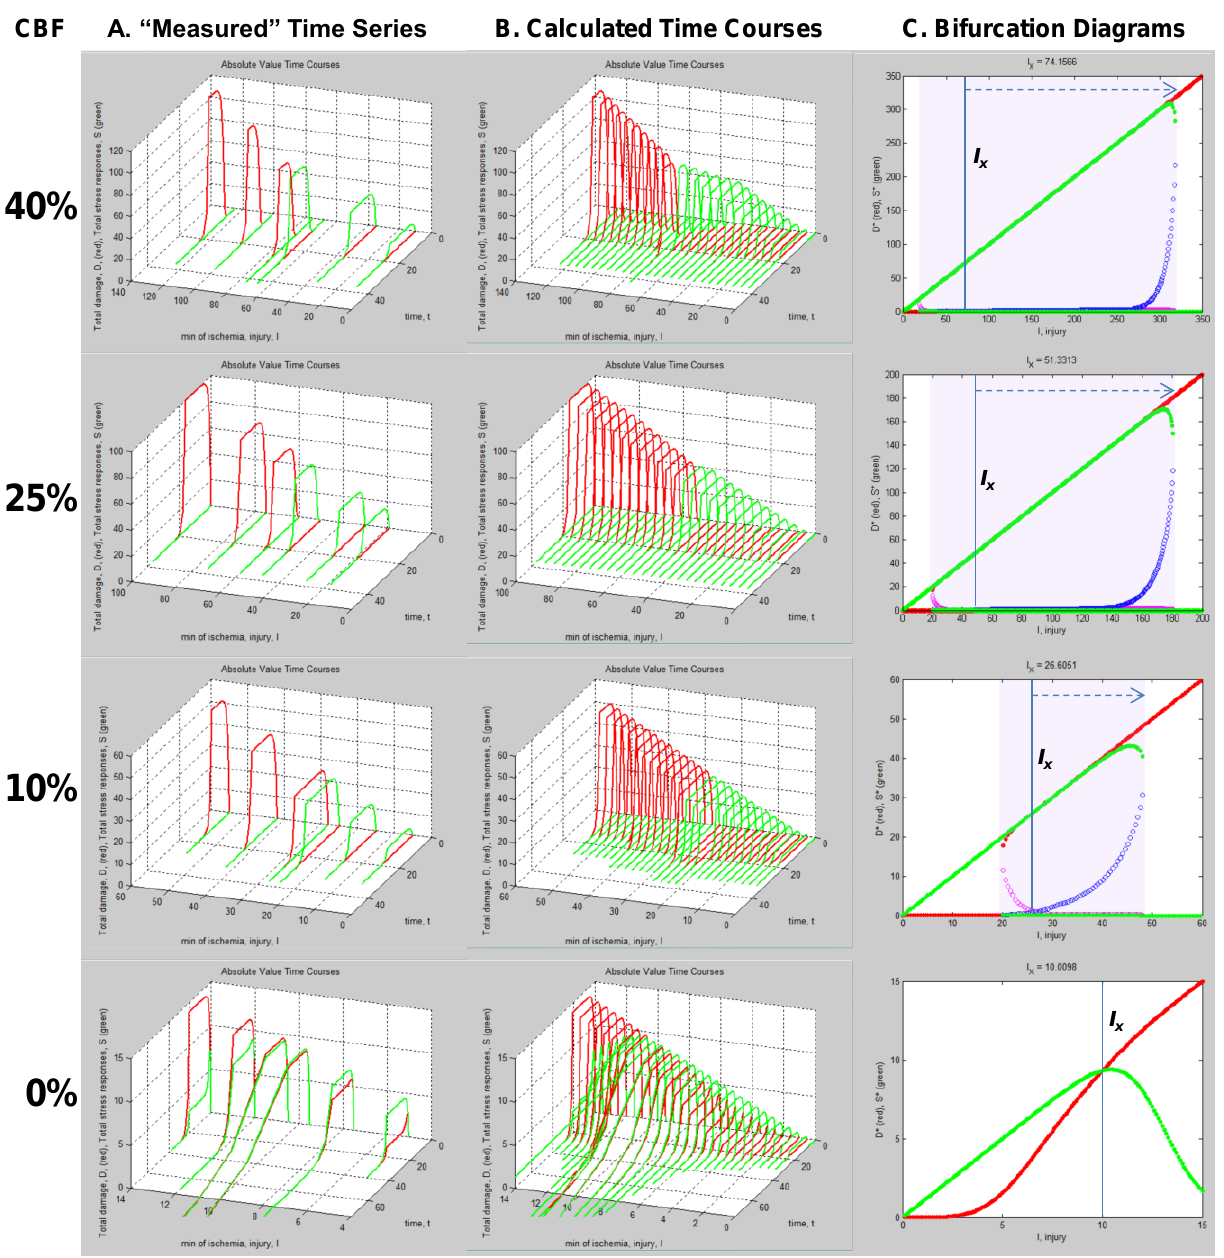
Figure 8. Plots calculated from fully determined model. ( A ) Repeats hypothetical time series experimental data from Figure 5. ( B ) Using Equations (1) and (2) to calculate intervening time courses that were not experimentally measured. ( C ) Using Equations (1) and (2) to calculate bifurcation diagrams that reveal if and where the system undergoes bistable phase transitions. Purple areas mark bistable regions. I is indicated by vertical line x on each bifurcation diagram. Dashed arrows mark therapeutic region on each injury